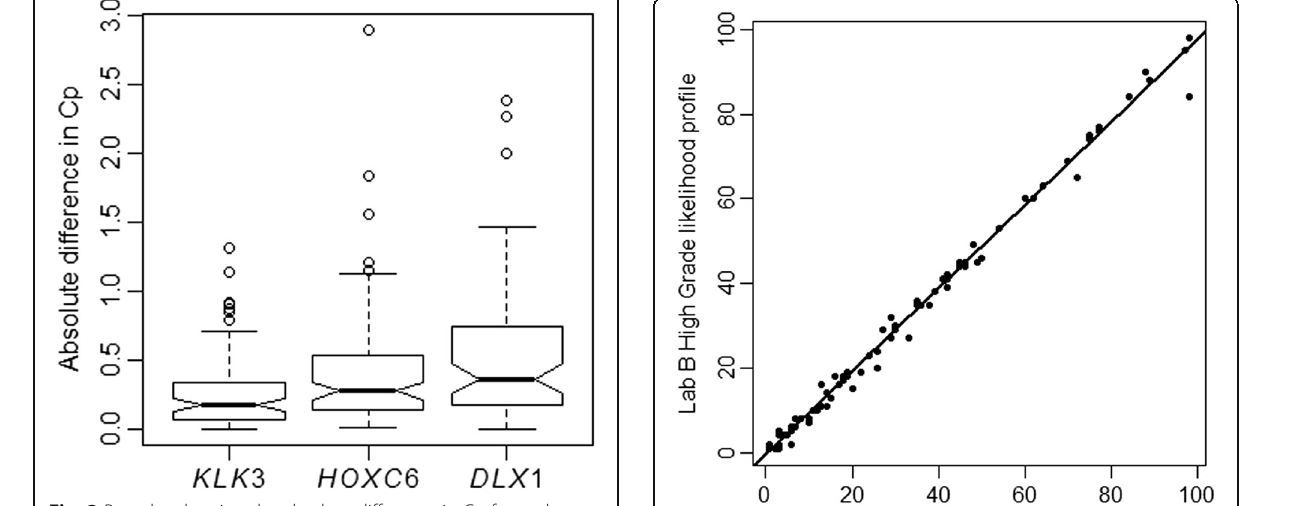
Fig. 3 Box plot showing the absolute difference in Cp for each target gene obtained for 99 urine samples analyzed at Lab A and Lab B. The box represents the inter-quartile range and the line in the box represents the median. The whiskers represent the minimum and maximum values observed. The open circles represent outliers